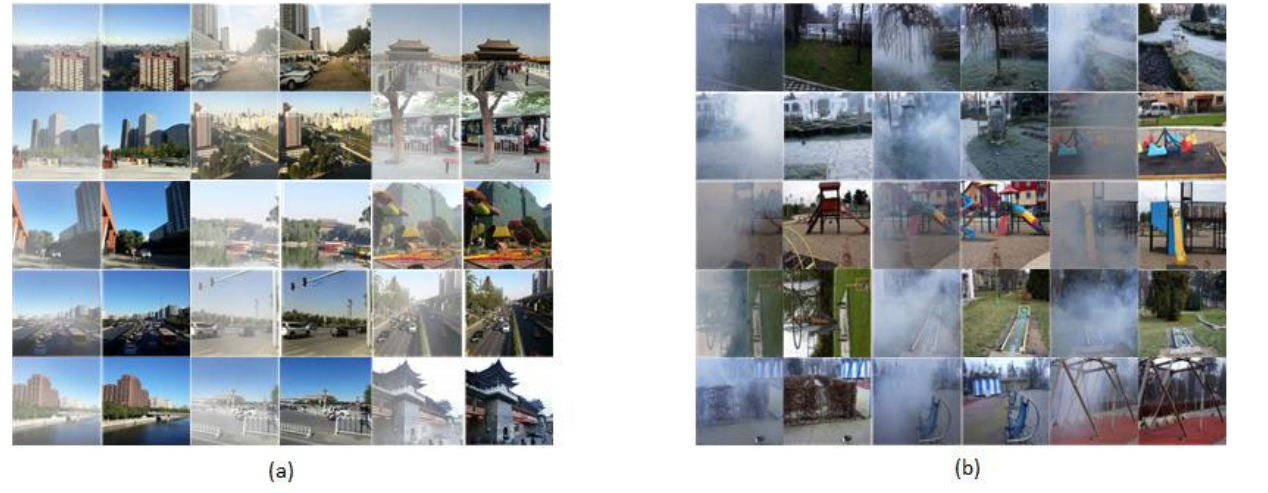
Figure 5. The training dataset: ( a ) Outdoor dataset; ( b ) NTIRE2020 ‐ Dhaze